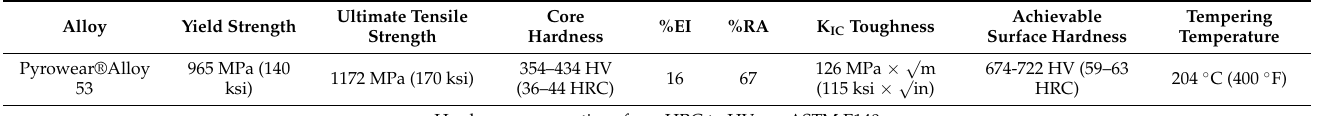
Figure 4. Bound chip on the tooth root, after power skiving machining.